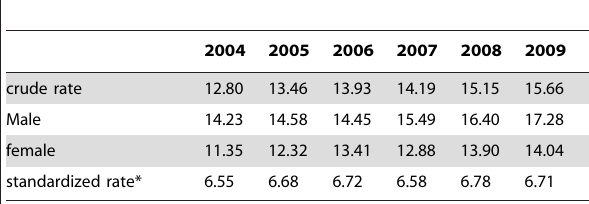
*Standardized by international age structure.